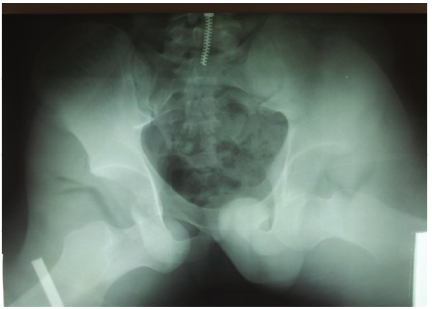
Figure 1: X-ray of a bilateral simultaneous traumatic obturator dislocation of both hip joints.